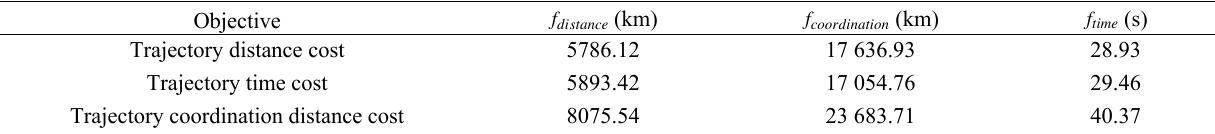
Table 2 Optimal trajectory for each